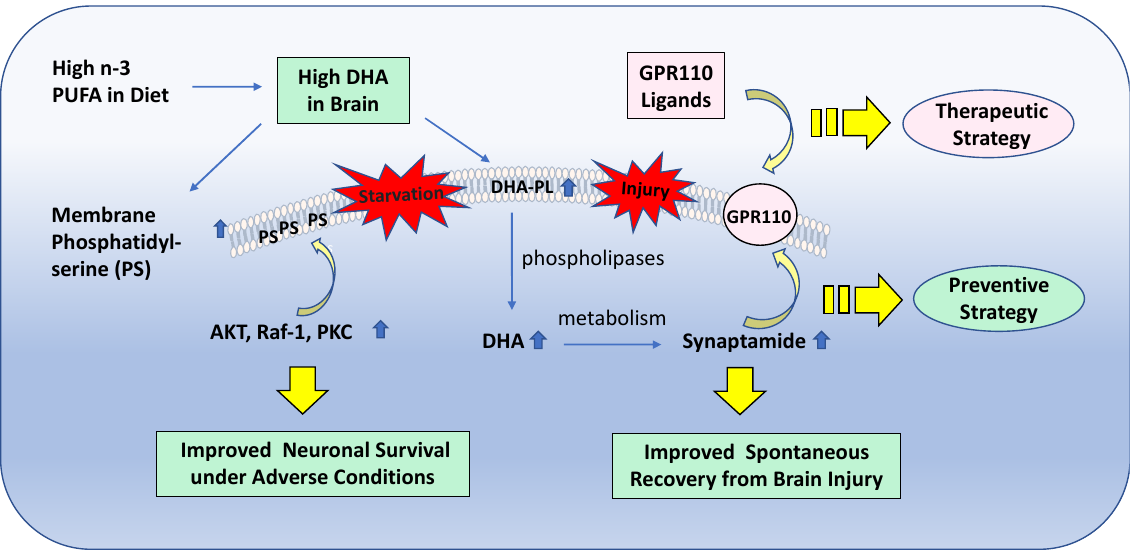
Figure 7. Preventive and therapeutic strategies for neuroprotection based on DHA-derived bioactivity. PUFA, polyunsaturated fatty acids; DHA, docosahexaenoic acid; DHA-PL, DHA-containing phospholipids. PKC, protein kinase C.